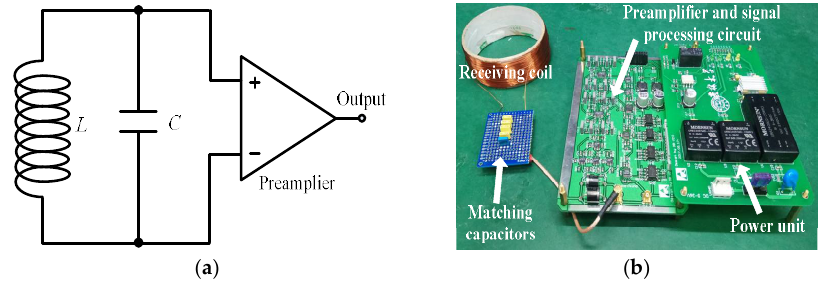
Figure 1. LC resonance magnetic sensor. ( a ) Schematic diagram; ( b ) sensor prototype.